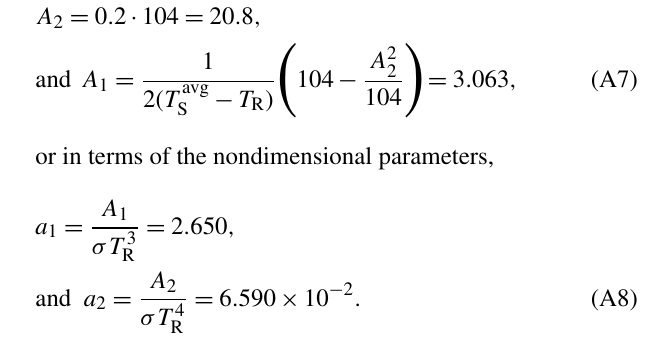
Figure A1. Graphs of the nondimensionalized EBM Eqs. (9)– (10). The red curves represent the surface EBM Eq. (10). The smooth red curves represent α ( T S ) as in Eq. (A3), with ω ≡ (cid:127) 0 . 001 , 0 . 01 , 0 . 02 , 0 . 5, on successively flatter red curves. The blue curve represents the atmosphere Eq. (9). There are up to three intersections of the blue curve Eq. (9) with a given red curve Eq. (10) in this figure. Other parameters in the EBM are α C = 0 . 7, α W = 0 . 08, δ = 0 . 67, µ = 400, F A = 45Wm − 2 , F O = 50Wm − 2 and Z =